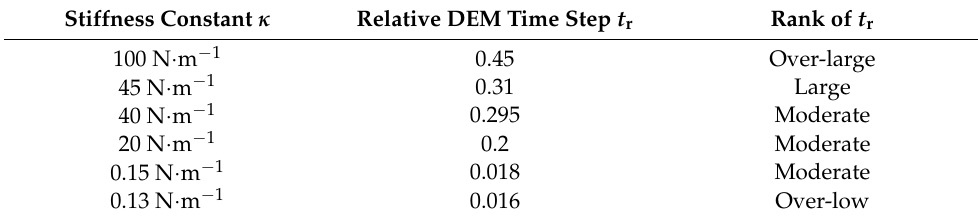
Table 2. Variable